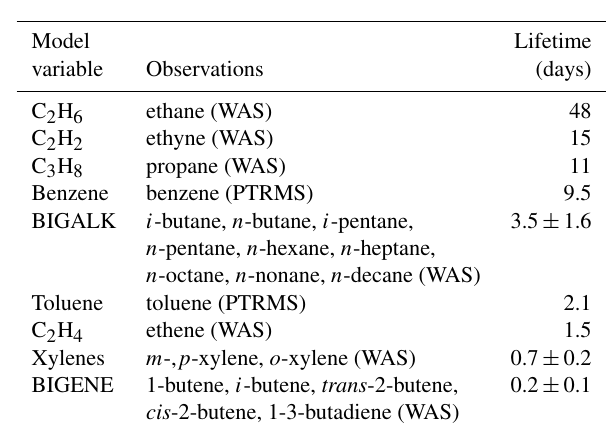
Table 3. VOCs added to the state vector, corresponding measur- ing instrument, and lifetime (Simpson et al., 2020) used for val- idation. For comparison with surrogate species, the sum of all the corresponding VOC observations is used. WAS stands for whole-air sampler.